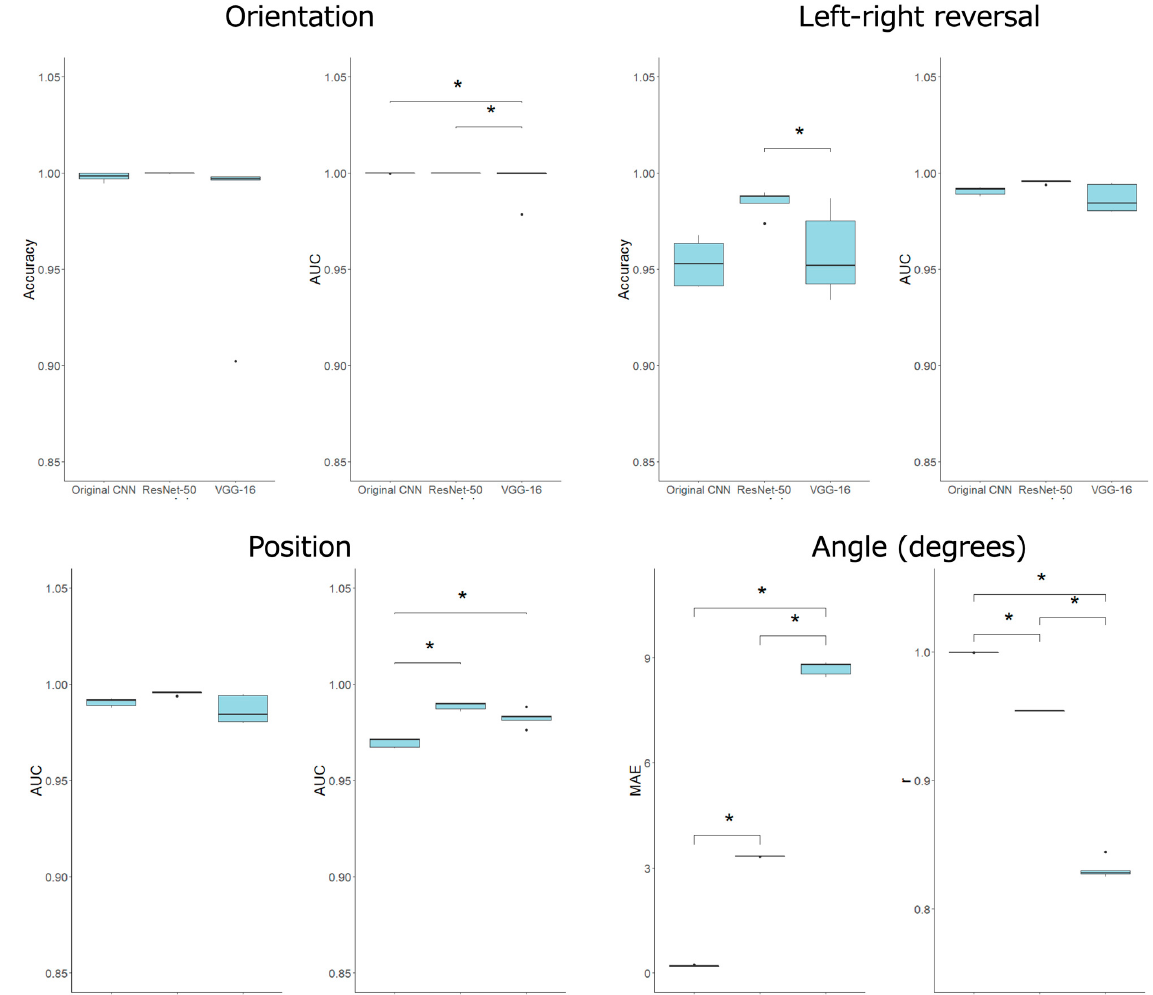
Figure 3. Summary of the accuracy and area under the curve of the receiver operating characteristics analysis. * p < 0.05